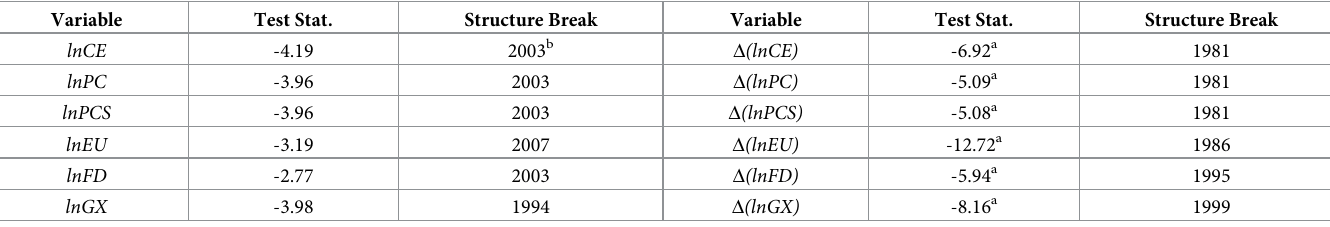
Table 1. Order of integration with a structural